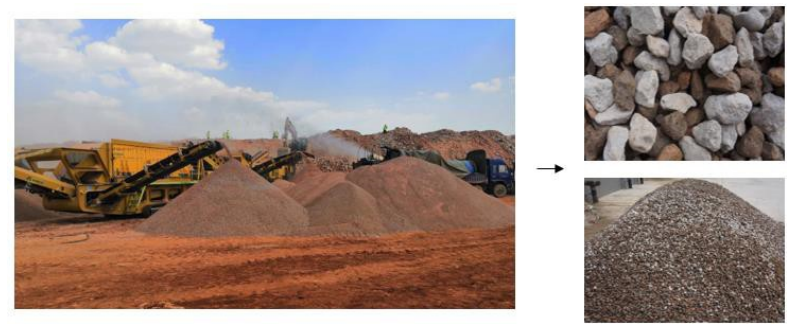
Figure 14. Mobile plant of CDW and MRA product.